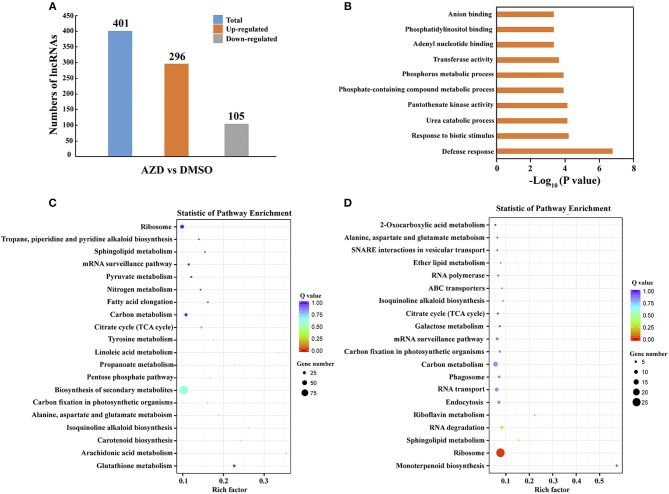
Differential expression of lncRNAs between DMSO and AZD treatment. (A) Compared with those in DMSO control, 296 lncRNAs were upregulated and 105 lncRNAs were downregulated in AZD treatment. (B) The top 10 enriched Gene ontology (GO) terms of differentially expressed lncRNAs. (C) Statistical KEGG enrichment of lncRNA target genes for upregulated differentially expressed lncRNAs using KOBAS software. (D) Statistical KEGG enrichment of lncRNA target genes for downregulated differently expressed lncRNAs using KOBAS software.